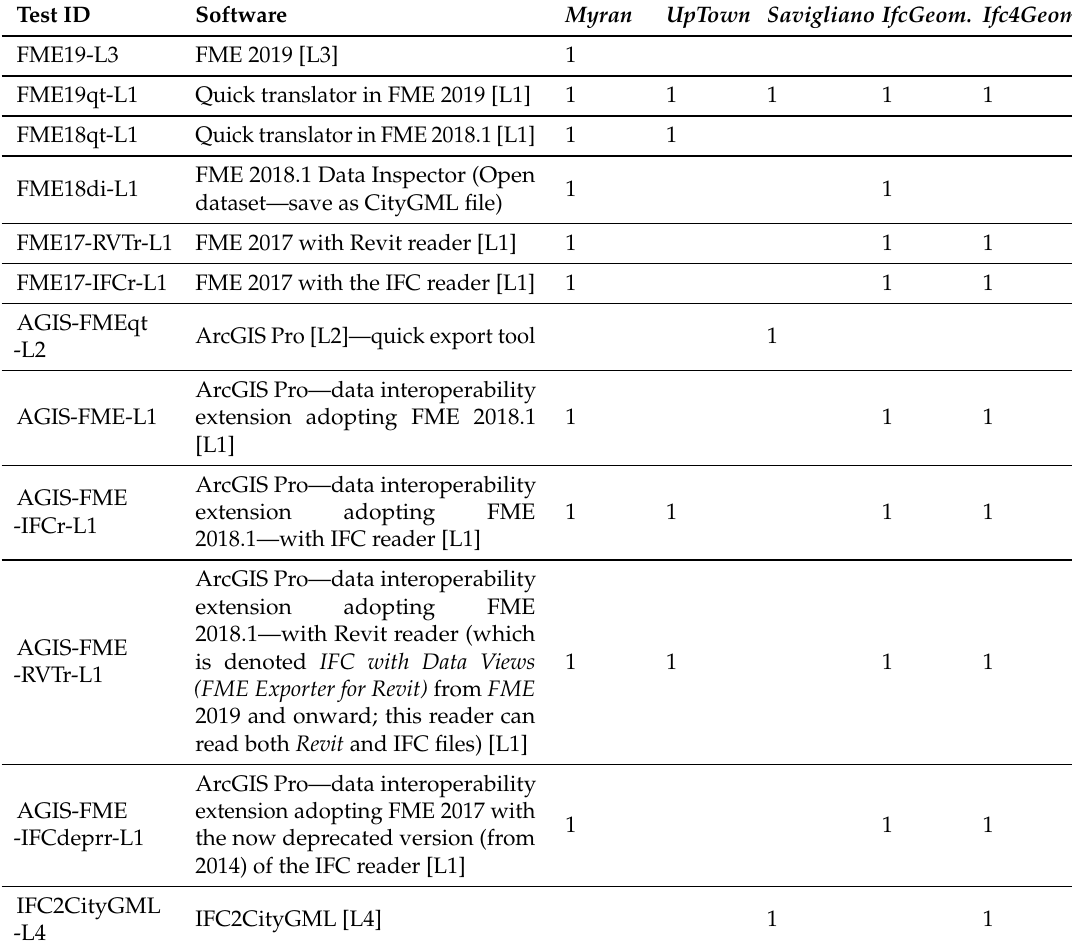
Table 9. Software tested for conversions form CityGML to IFC (Task